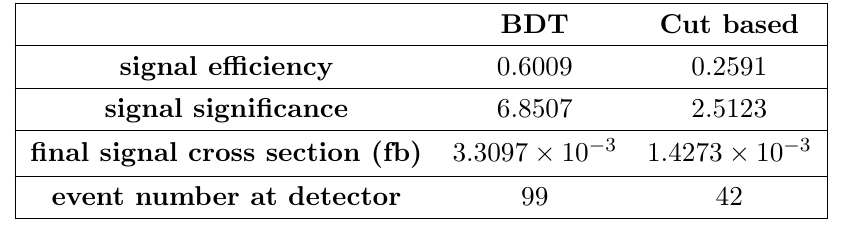
Table 10 . Comparison between BDT and cut-(cid:13)ow based results at L = 30 ab (cid:0) 1 for pp ! H (cid:6)(cid:6) H (cid:7) ! W (cid:6) W (cid:6) hW (cid:7)